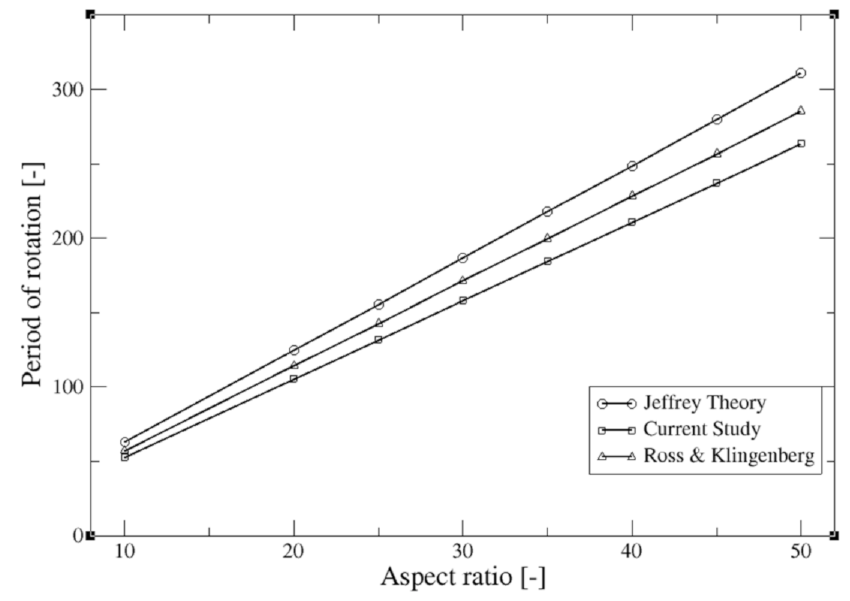
Figure 6. Validation of the implemented spheroid fibre model against Jeffrey orbit theory [35] and Forgacs and Mason